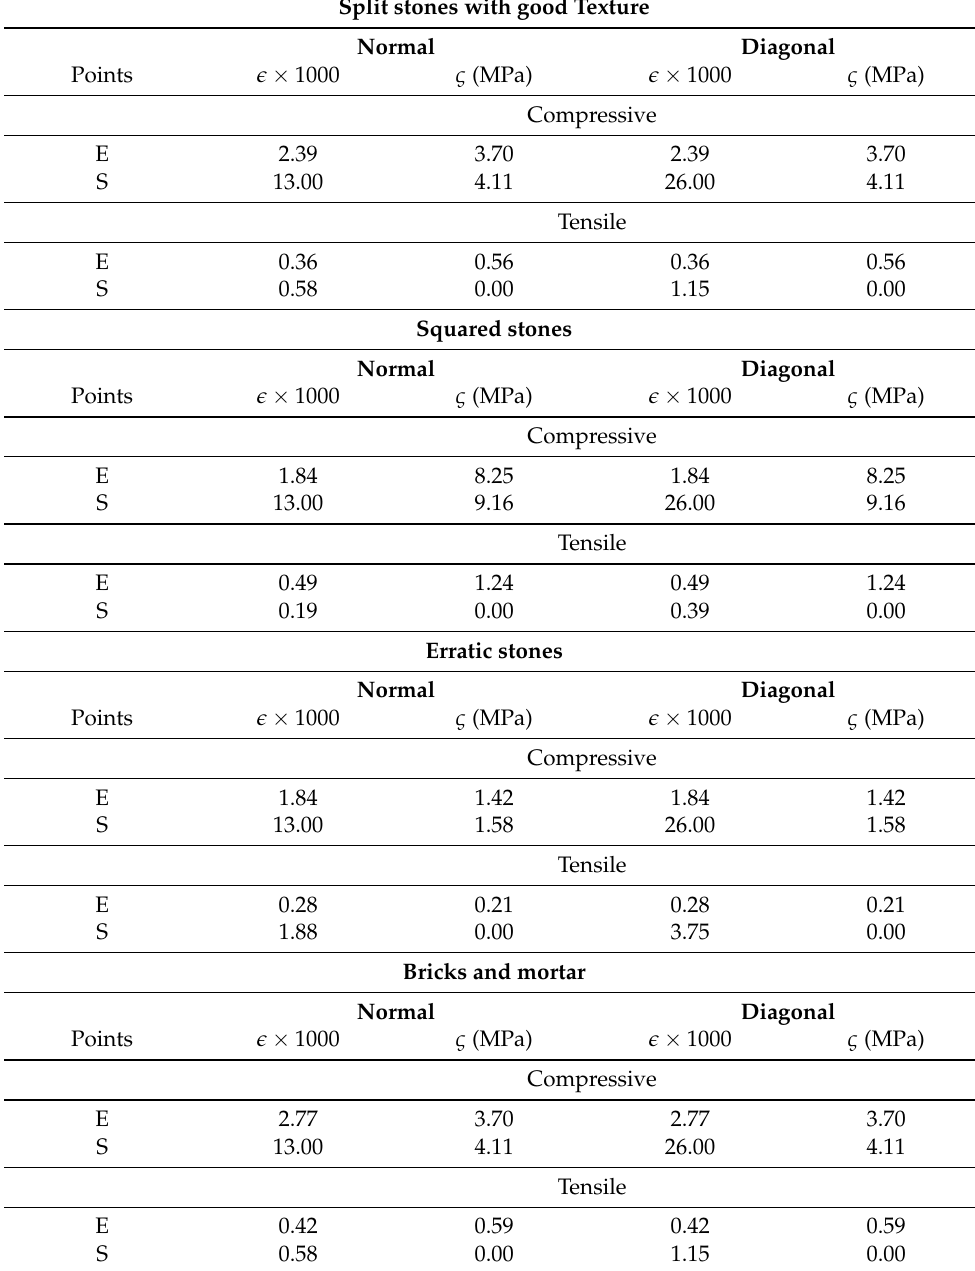
Table 4. RBSM spring constitutive behaviors for the different materials. Split stones with good